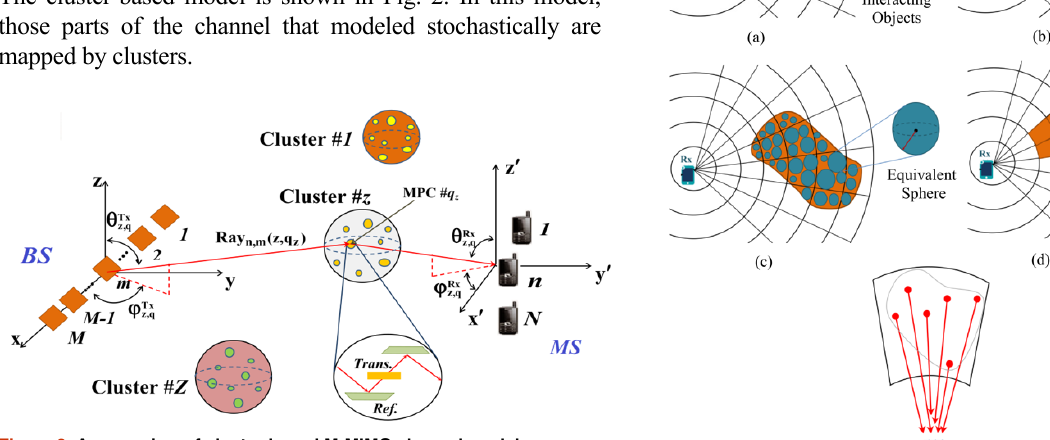
Figure 2. An overview of cluster-based M-MIMO channel model.